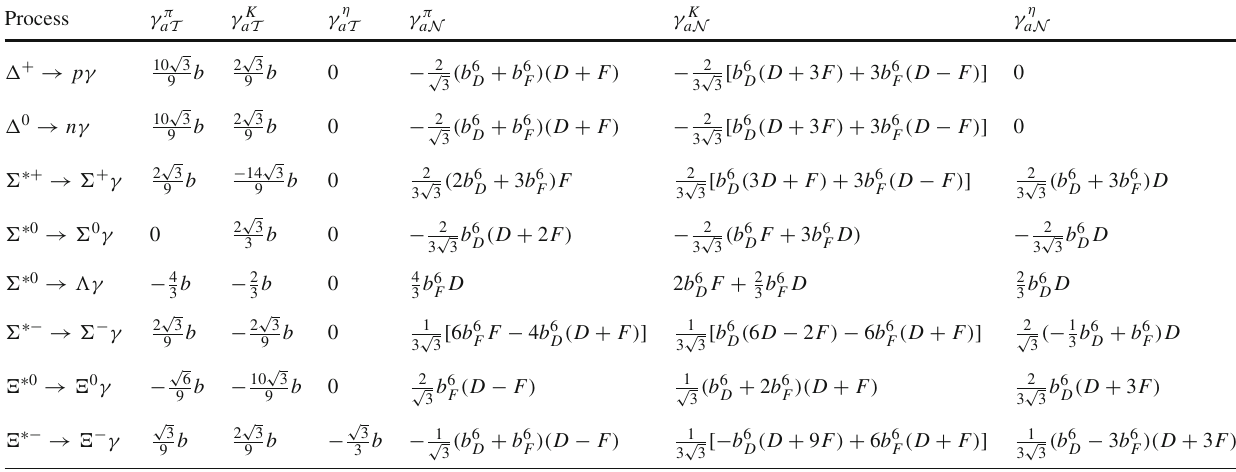
Table 9 The coefficients of the loop corrections to the decuplet to octet baryon transition magnetic moments from Figs. 2(e) and 2(f) Process